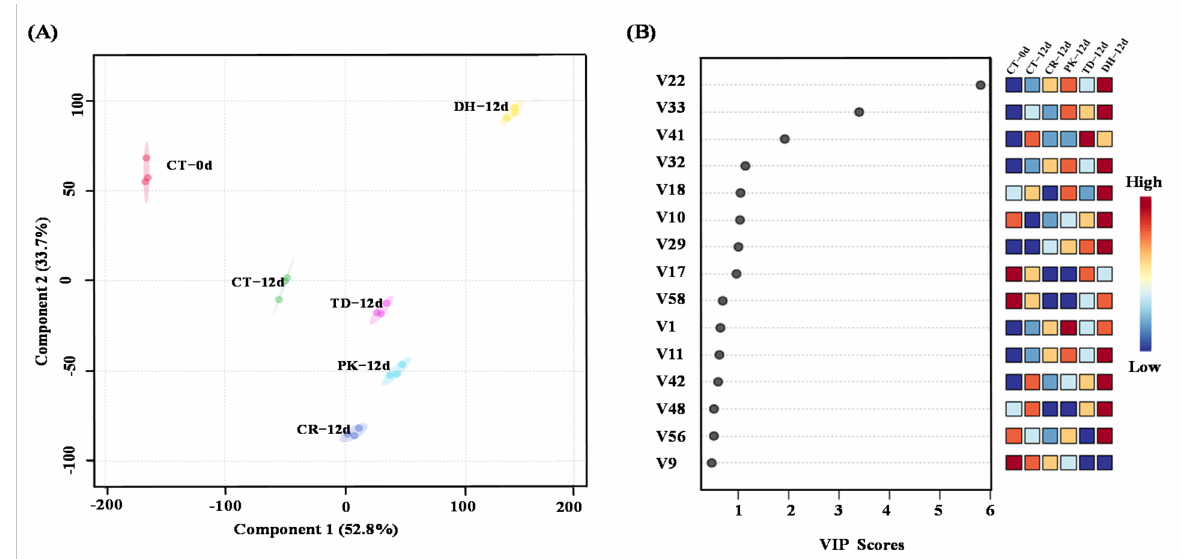
Figure 3. Partial least squares-discriminant analysis score plot ( A ) and the top 15 variables impor- tant in the projection (VIP) values ( B ) of all volatile compounds for the control and reduced-salt dry sausages with and without yeast inoculation on days 0 and 12. V9-V58: the numbers of the correspond- ing volatile compounds in Table 5. CT: 2.50% NaCl; CR: 1.75% NaCl; PK: 1.75% NaCl + P. kudriavzevii ; TD: 1.75% NaCl + T. delbrueckii ; DH: 1.75% NaCl + D. hansenii